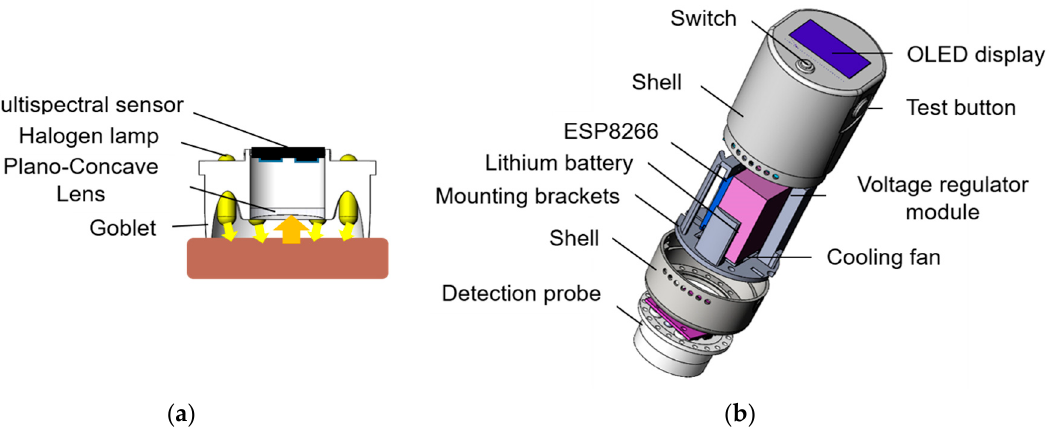
Figure 1. Detector structure diagram: ( a ) Schematic diagram of the detection probe; ( b ) Schematic diagram of detector structure.